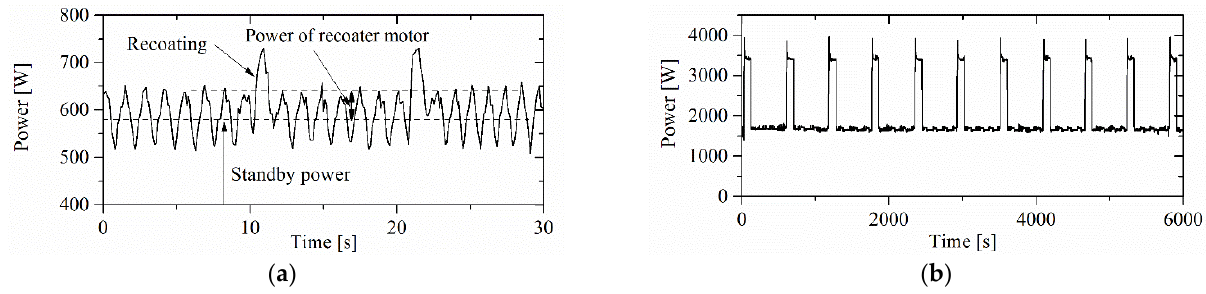
Figure 10. The power profile of: ( a ) Recoater motor; ( b ) Basic components.